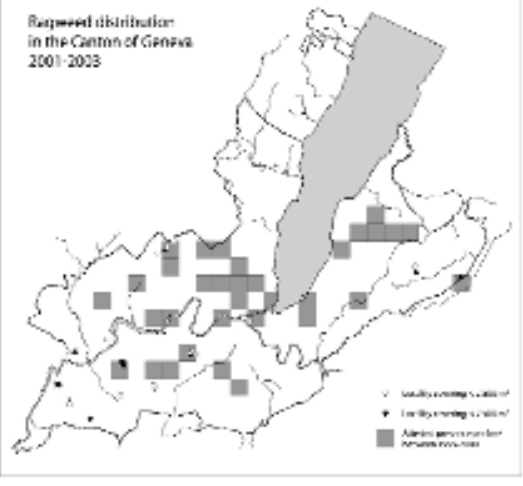
Common ragweed distribution in Geneva at the end of